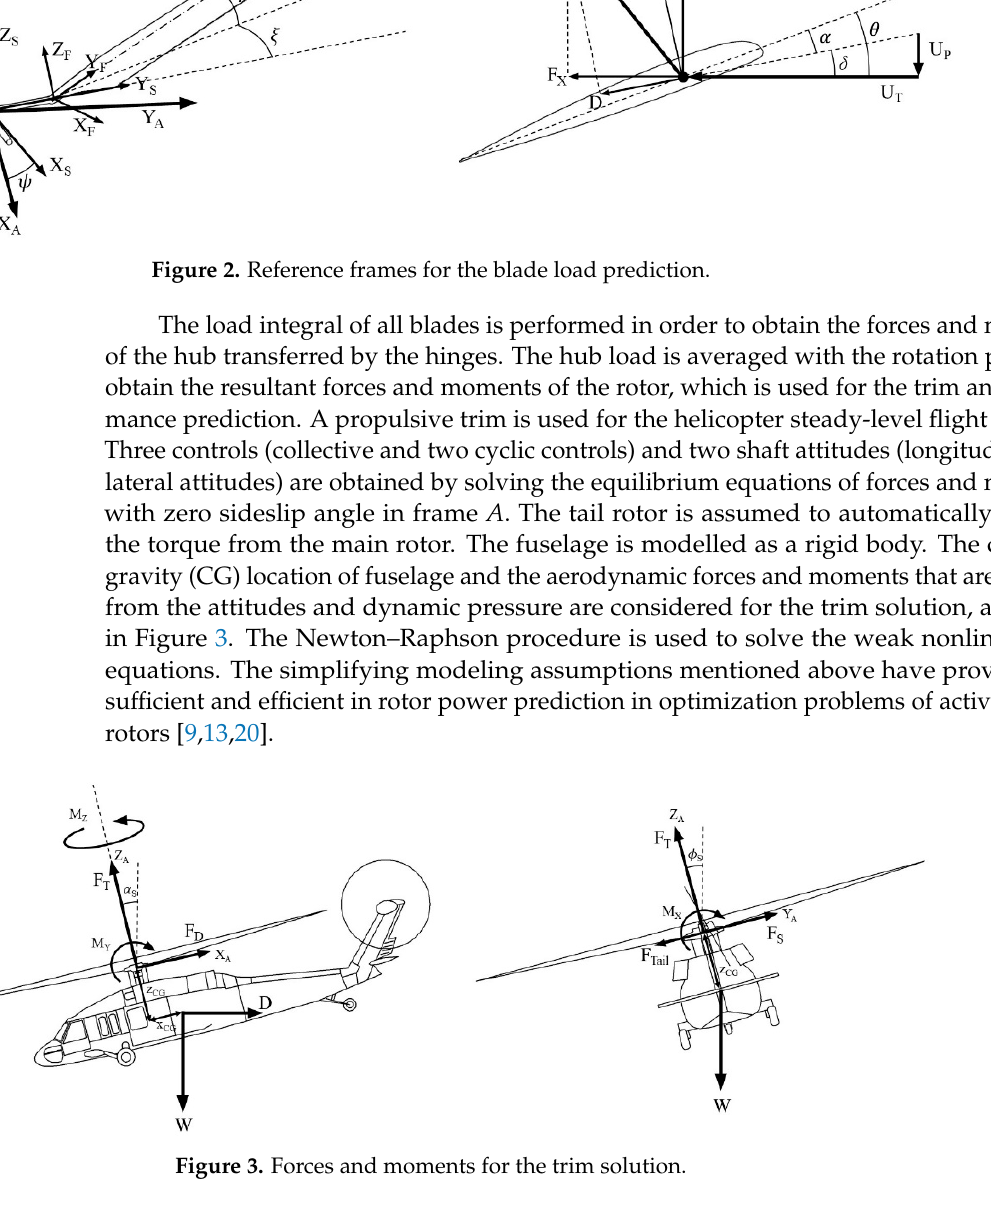
Table 1. Baseline helicopter attributes. Attribute Radial Position Figure 4. Pre-twist distribution of the UH-60A blade.